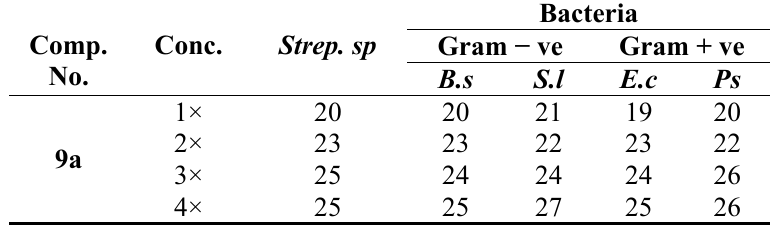
Table 4. Antibacterial activity of compound 9a at different concentrations.